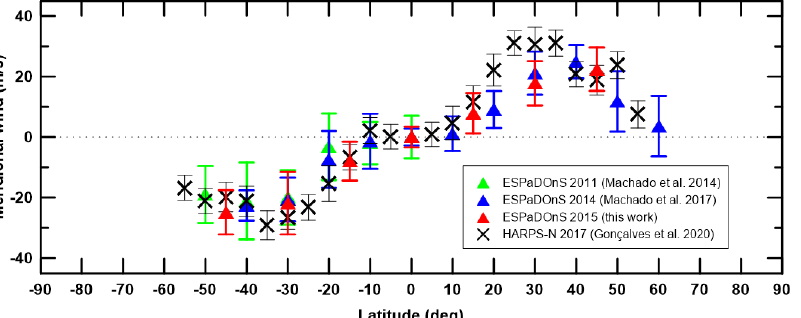
Figure 6. Comparison of meridional wind latitudinal profiles obtained with Doppler velocimetry tech- nique along several observation campaigns. All results were obtained using the same method and all ob- servations were made with a fiber-fed high-resolution spectrograph—this work and Machado et al. [8,10] used ESPaDOnS at CFHT; Gonçalves et al. [12] used the